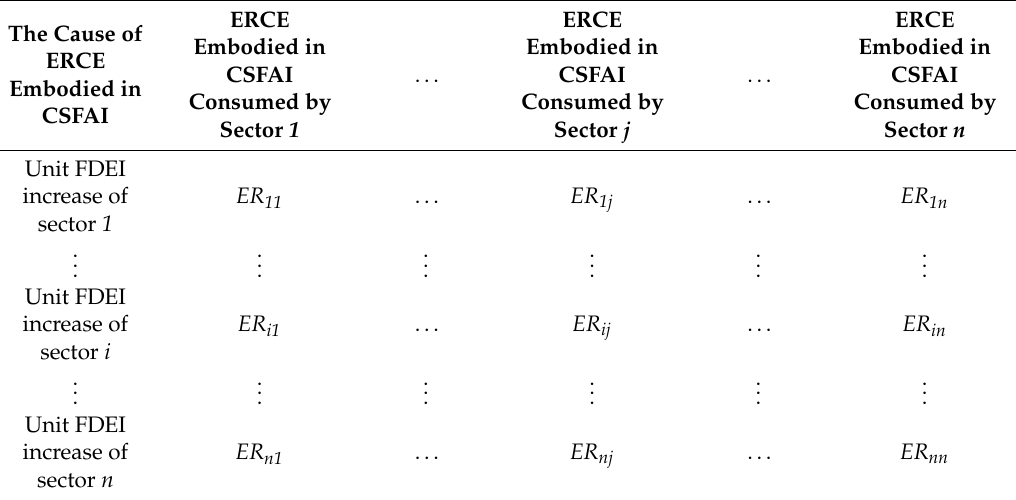
Table 2. Format of DHI / O–SDA model results